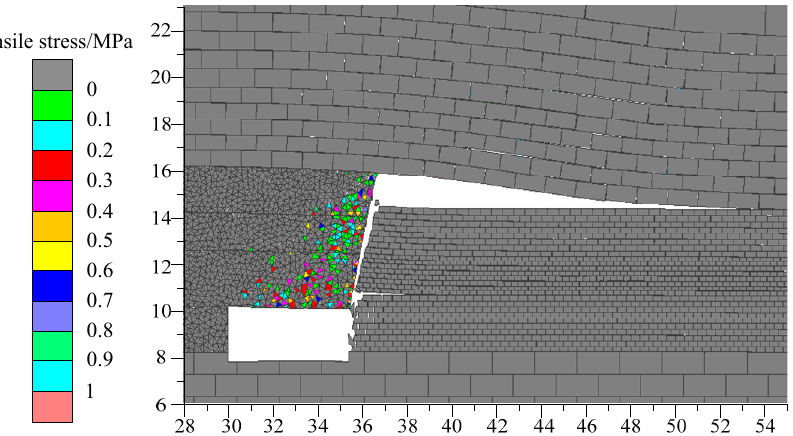
Figure 12. Simulated localized tensile stress distribution map in the entry-surrounding rock in a supported condition.